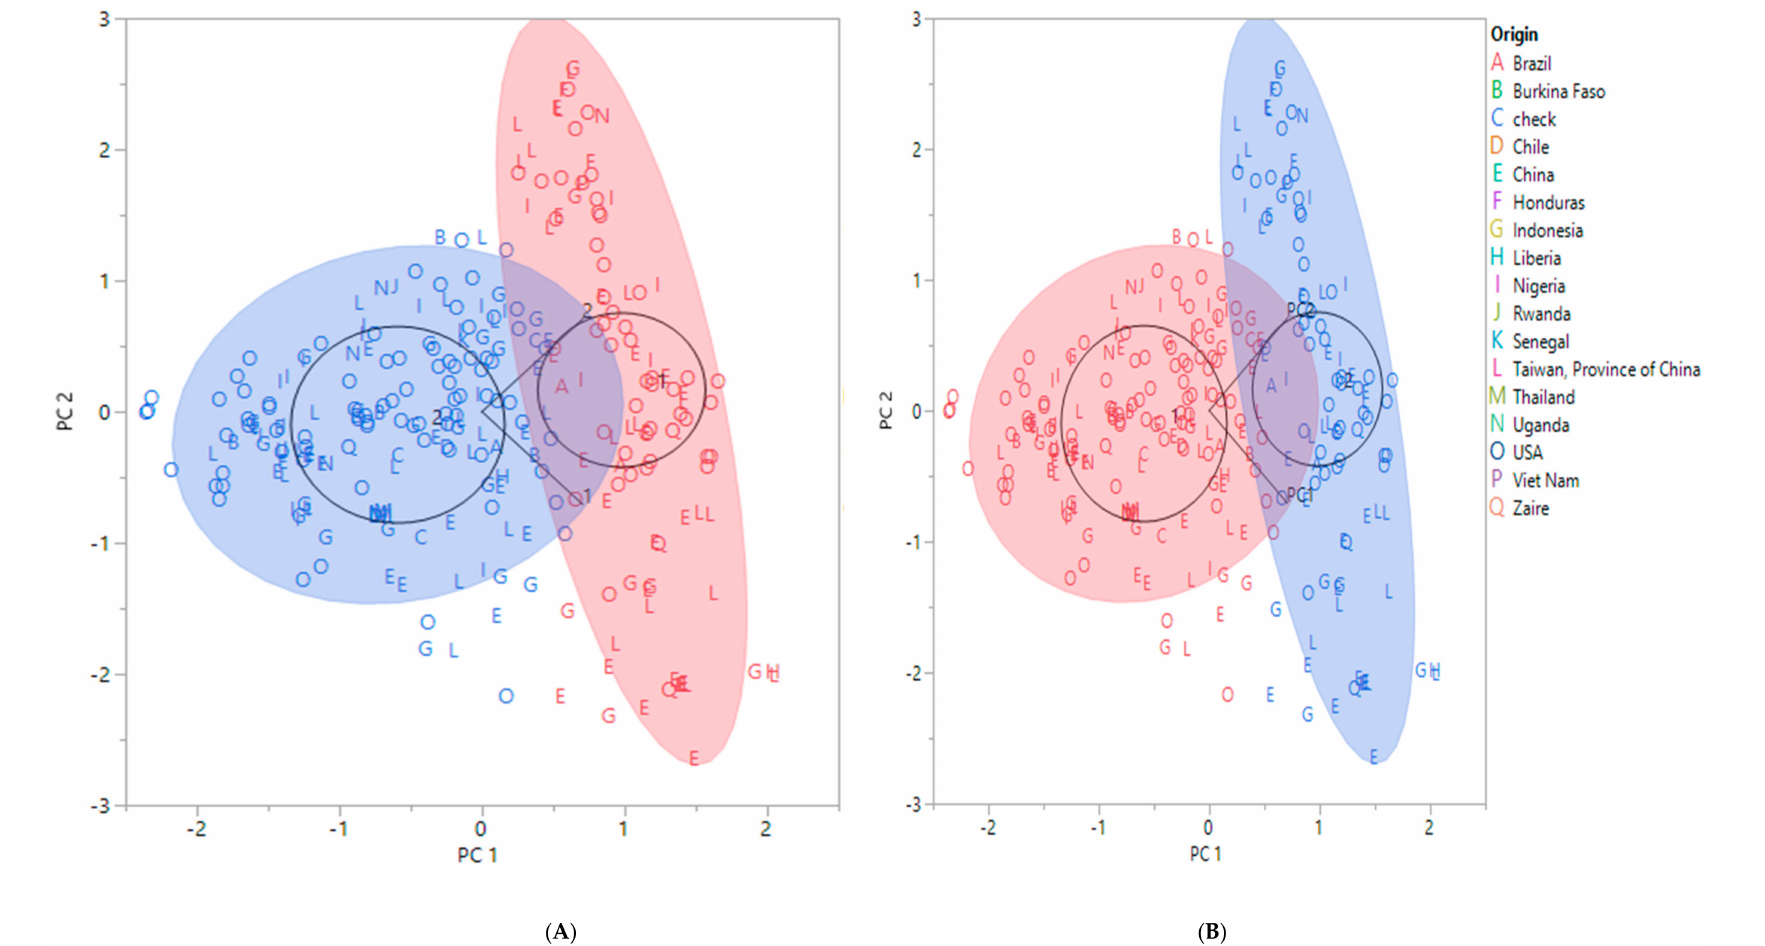
Figure 2. Principal component analysis biplot showing the first two components: ( A ) SNP markers and ( B ) DArT markers. The blue- and red-filled circles indicate the two groups identified. The black circles also represent the two groups and show the labels of the groups (1 and 2). The black line indicates the